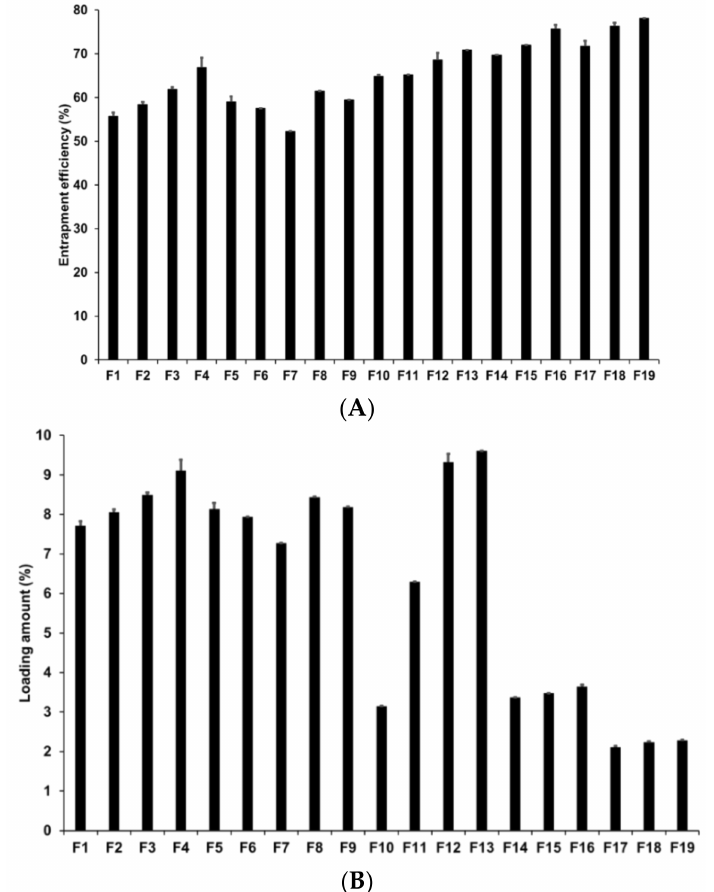
Figure 3. Loading efficiency and loading amount of AD-loaded SLNs. Results are expressed as the means ± standard deviations of three independent experiments ( n = 3). ( A ) Loading efficiency and ( B ) loading amount of AD-loaded SLNs prepared using different compositions of AD, lipids, surfactants. AD, adenosine; PDI, polydispersity index; SLNs, solid lipid